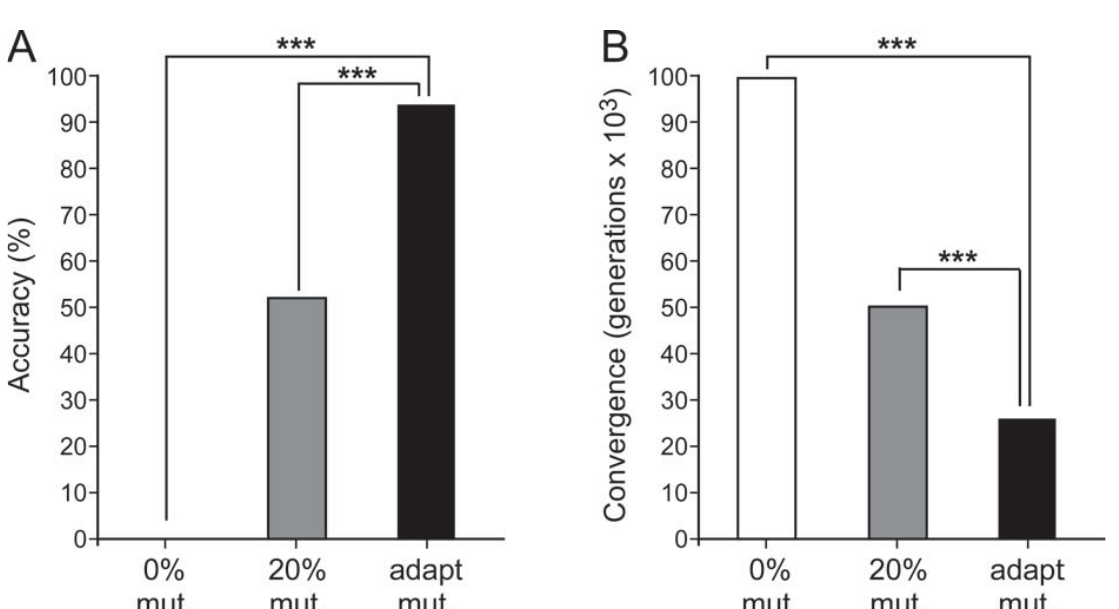
Figure 5. N-queens accuracy and convergence results for constant and adaptive mutation rate genetic algorithms. A . Graph of the N-queens problem accuracies among 0% constant mutation, 20% constant mutation, and adaptive mutation. ***p < 0.001. B . Graph of the N-queens problem convergences among 0% constant mutation, 20% constant mutation, and adaptive mutation. ***p < 0.001. mutation (mut.), adaptive (adapt.).